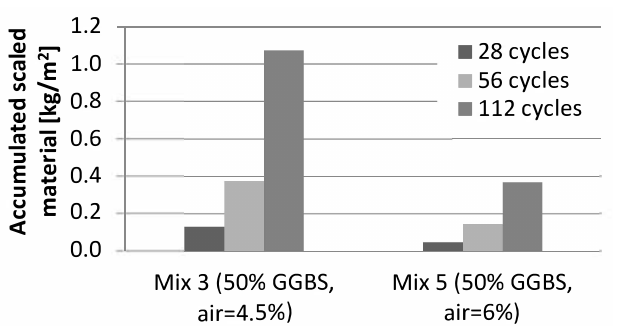
Figure 17. Mean values of the accumulated mass of scaled material per area of freezing surface after 28, 56 and 112 cycles for concrete with 50% GGBS and di ff erent air